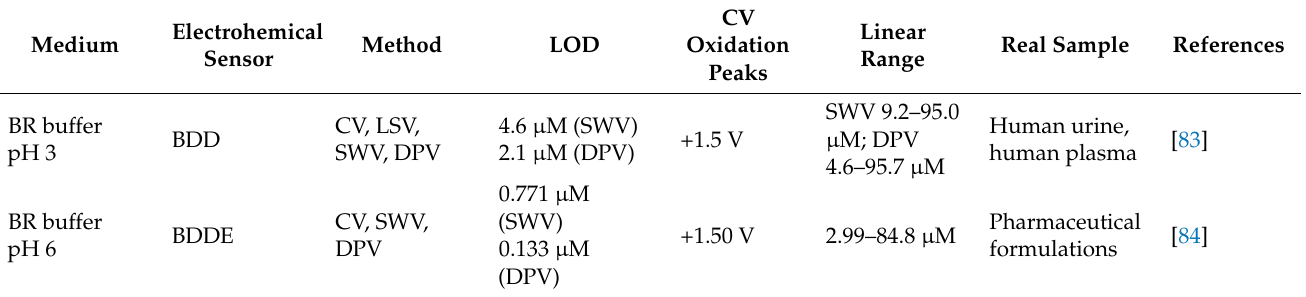
Table 4. Electrochemical characteristics of boron-doped diamond electrode as sensor for caffeine